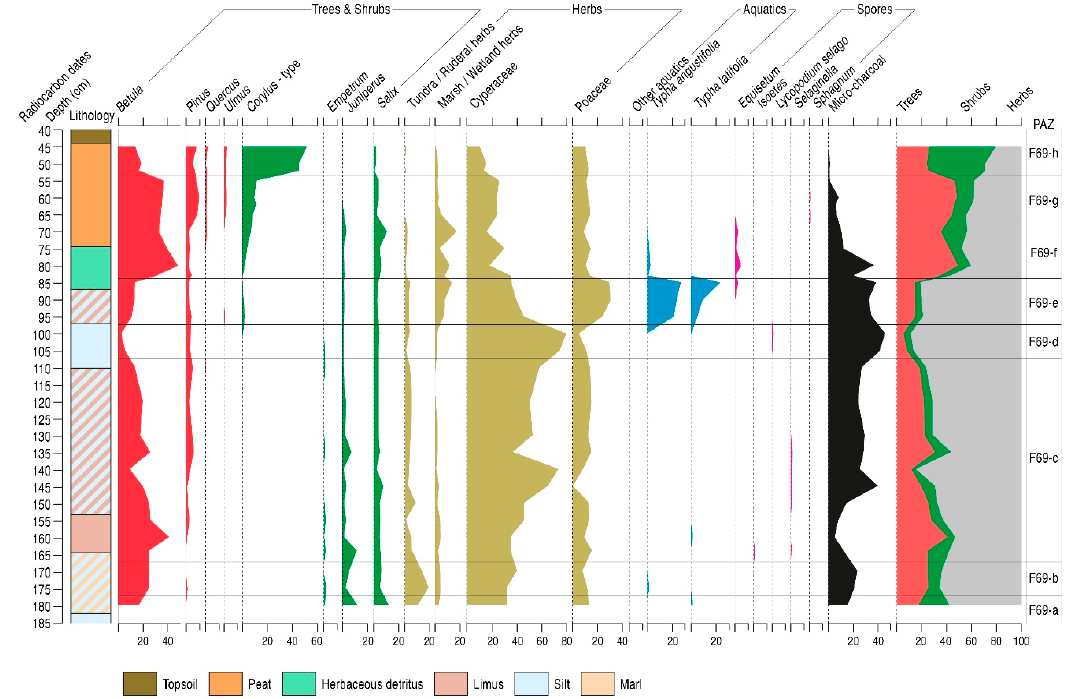
Figure 6. Summary pollen diagram from Nosterfield the Flasks core 69. Frequencies are calculated as percentages of total land pollen. For lithology [57], see Table 3. For radiocarbon dates, see Table 1 and Figure 7.